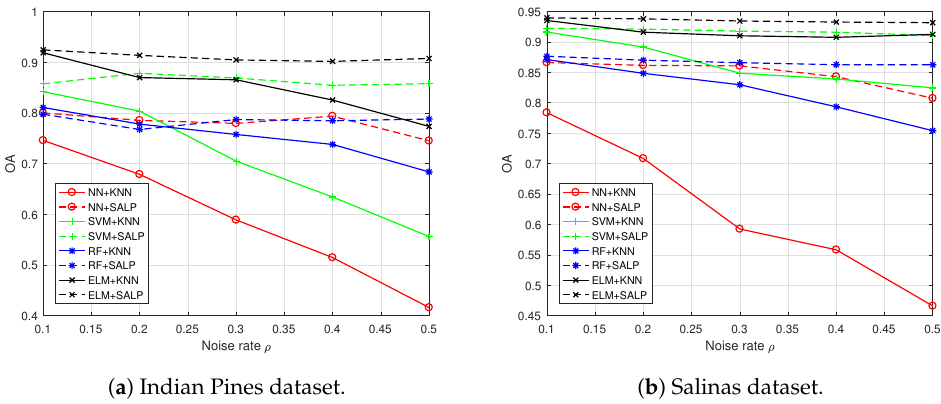
Figure 11. OA of KNN graph and SALP with the “both” Setting. The proposed SALP is marked by imaginary line, and KNN graph is marked by solid line. The results of NN, SVM, RF and ELM are labeled in red “o”, green “+”, blue “*”, and black “x”.